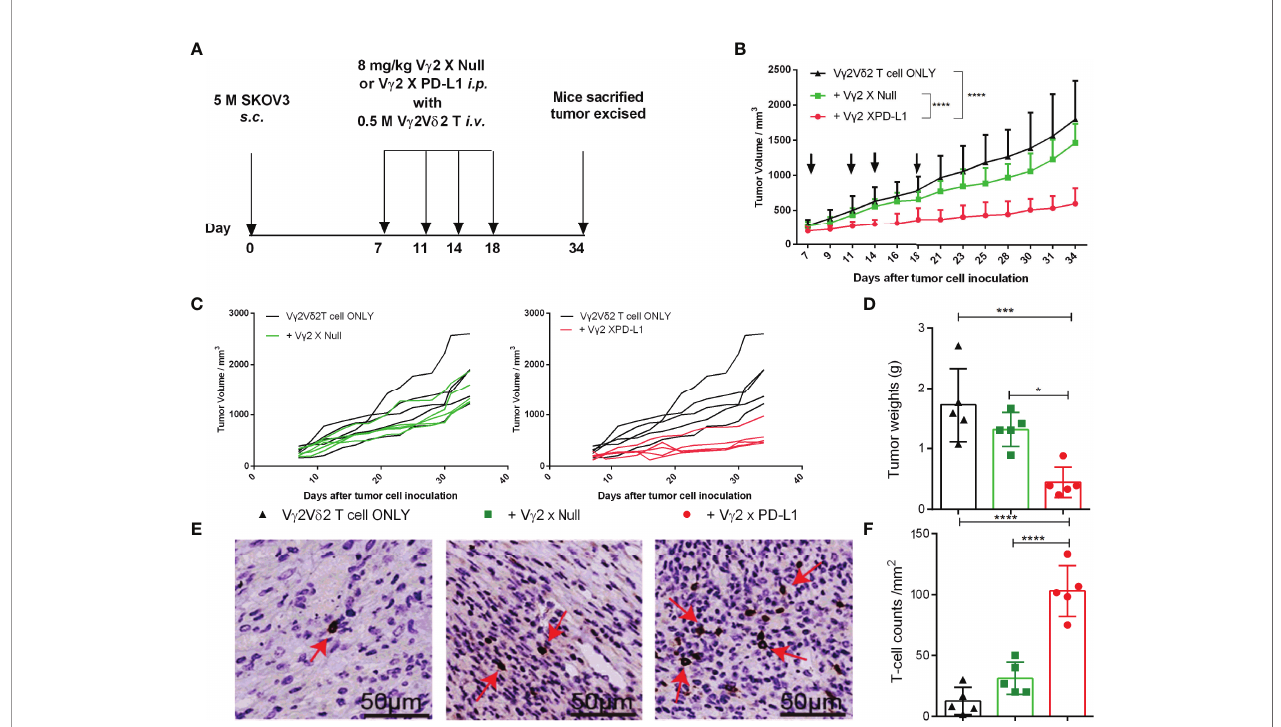
FIGURE 7 | V g 2 X PD-L1 prompted the survival of inoculated V g 2V d 2 T cells in nude mice. (A) Experimental schema of evaluating the anti-tumor therapeutic ef fi cacy of V g 2 X PD-L1. Nude mice were s.c. inoculated with 5 million SKOV3 cells on Day 0. After 15 days, mice were treated with i.v. V g 2V d 2 T cells plus 8 mg/kg V g 2 X Null or V g 2 X PD- L1. These treatments were repeated twice a week (Q2W) for 3 weeks. Mice treated PBS only were used as control. (B, C) Pooled or individual tumor growth curves. The black arrows indicated the treatment time point. Data are mean ± SD with 5 mice per group, **** p <0.0001 (Two-way ANOVA, Dunnett ’ s test), which was determined based on the tumor volumes at the end of the study. (D) Tumor weights at the end of the study. Data were mean ± SD with 5 mice per group, *** p <0.001, * p <0.05 (ANOVA, Dunnett ’ s test). (E, F) In fi ltrated and accumulated T-cell counts at the tumor site. Representative IHC fi gures for the treated group (E) and pooled T cell counts (F) were presented as mean ± SD, **** p <0.0001, (ANOVA, Dunnett ’ s test). Data shown was one of two independent